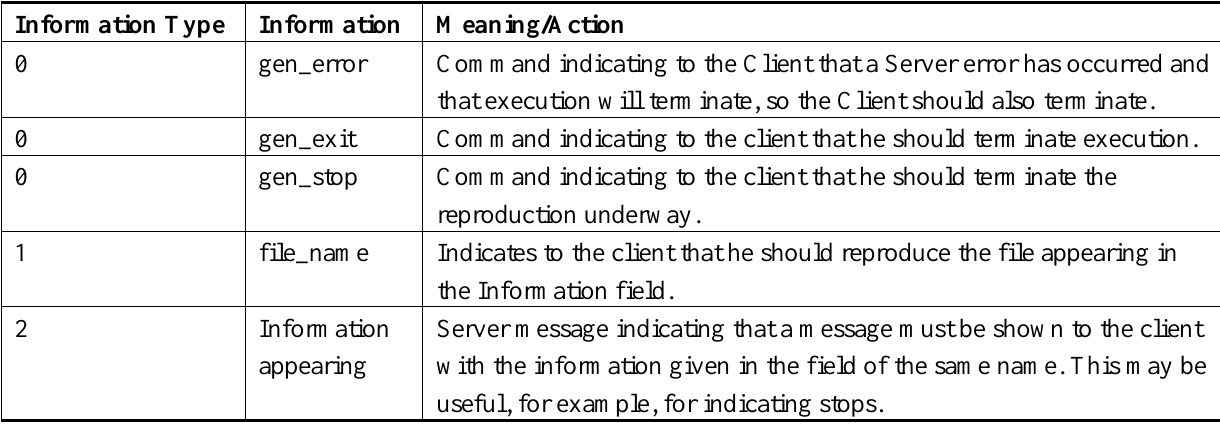
Table 1. Types of information and values used in the data